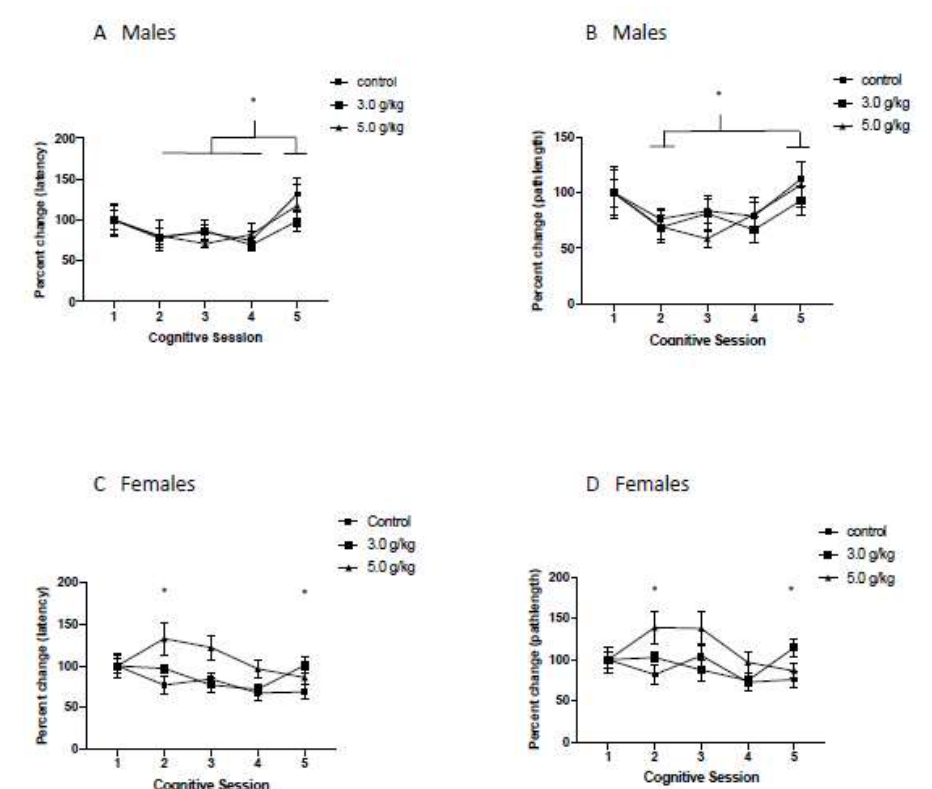
Figure 6. Chronic Intermittent Ethanol Exposure During Adolescence Impairs Relearning in Female Rats as a Function of Age. Percent performance of relearning (i.e., day 2 during each behavioral flexibility testing session) for each cognitive session for males ( A , B ) and females ( C , D ) when measured by either latency to the platform ( A , C ) or swimpath to the platform ( B , D ). For males ( A , B ) chronic intermittent ethanol did not alter relearning performance while age (as measured by increased cognitive session) did impair relearning. Brackets indicate significant post hoc tests while error bars denote standard error of the mean. * p < 0.05, exact values provided in manuscript. For females ( C , D ) chronic intermittent ethanol significantly impaired relearning due to the age of the animal. * denotes significant difference within each cognitive session, please see text for exact values. * p < 0.05, exact values provided in manuscript. Error bars denote standard error of the means. A value above 100% indicates impaired performance relative to performance in CS1 while a value below 100% indicates improved performance relative to performance in